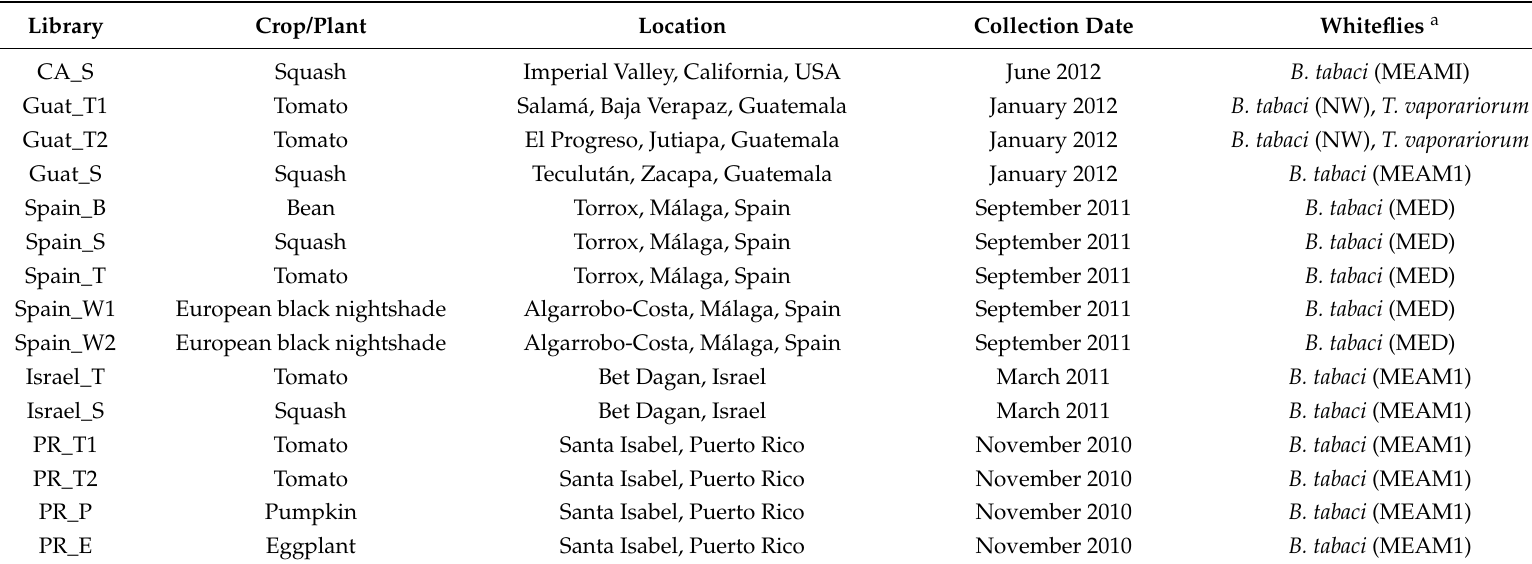
Table 1. Information about whitefly samples used during this